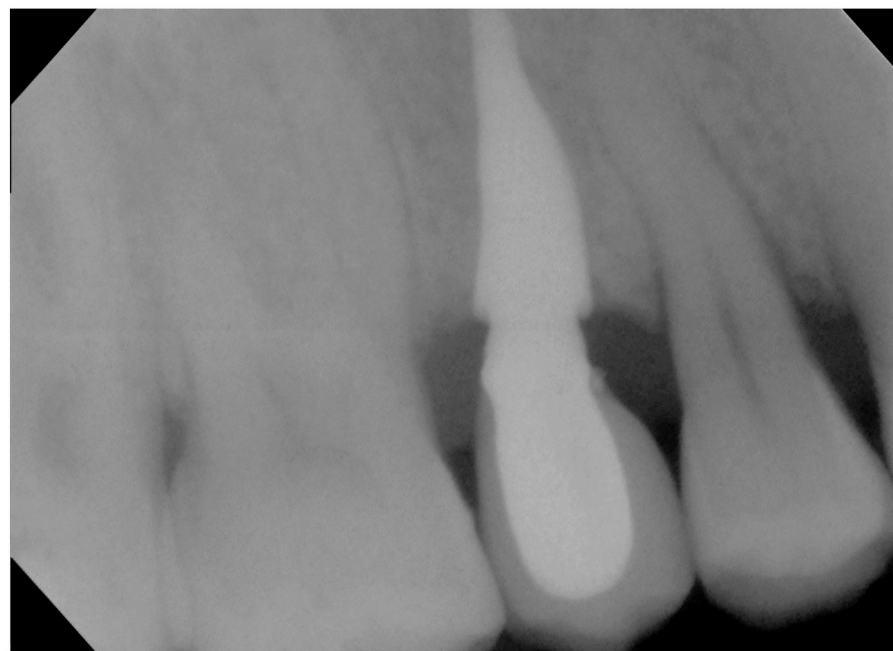
Figure 6. Rx with customized resin check 10 years after the